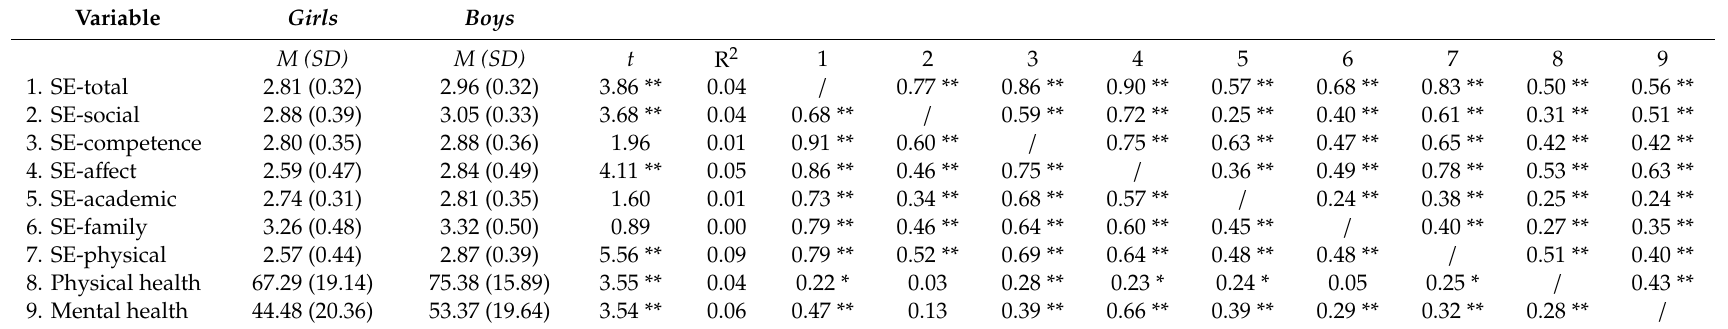
Table 2. Descriptive statistics by gender, t -value ( df = 323 for all variables except physical and mental health: df = 319), and correlation coe ffi cients by gender (girls above the diagonal). SE = Self-E ffi